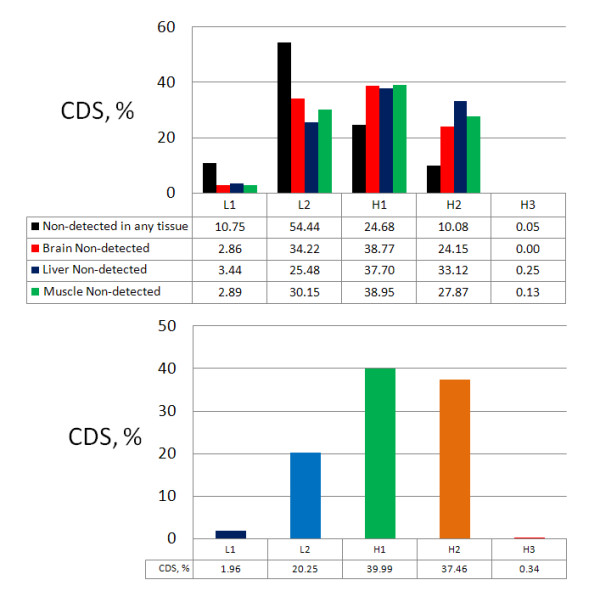
Isochoric distributions for the non-detected genes and the total number of CDSs. Top: Distribution (%) across the isochore families of the genes not detected to be expressed in any of the three tissues (bars in black), and of the genes not detected to be expressed in a specific tissue only (red bars for brain, blue bars for liver, and green bars for muscle). Bottom: Distribution (%) of the total number of coding sequences across the five isochore families (each coloured bar corresponds to an isochore family).